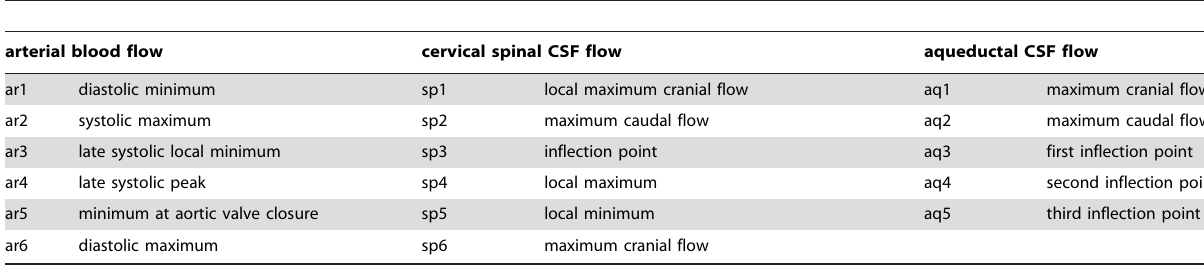
Table 2. Legend of waveform feature points (Fig. 1) in the corresponding compartments.